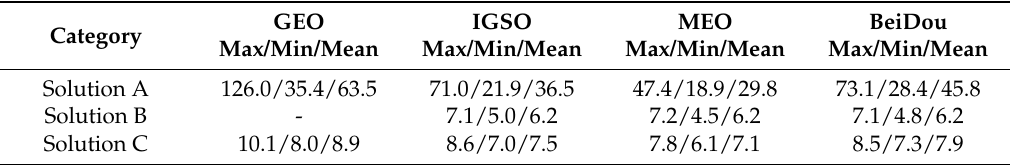
Table 4. Maximum, minimum, and average daily RMS series of phase residuals for GEO, IGSO, MEO, and all BeiDou satellites from solution A, B, and C in FY-3C POD during July 2017 (unit: mm).